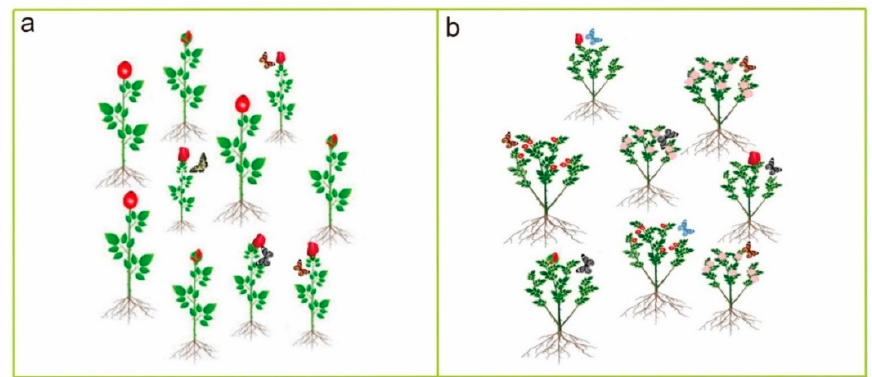
Figure 6. Can insects identify different ploidy level plants? According to Segraves and Anneberg [185], insects forage more on predominant cytotypes in a natural habitat where different ploidy plants coexist (( a ); where we imagine that small plants are predominant here, insect will forage more on small plants rather than flowers of bigger plants, i.e., irrespective of ploidy level). Contrarily, insects forage equally in a common garden where mixed cytotypes are grown (( b ); imagine there are different ploidy levels flower in the common garden. Insects generally fail to detect different ploidy levels; thus, they forage equally in a common